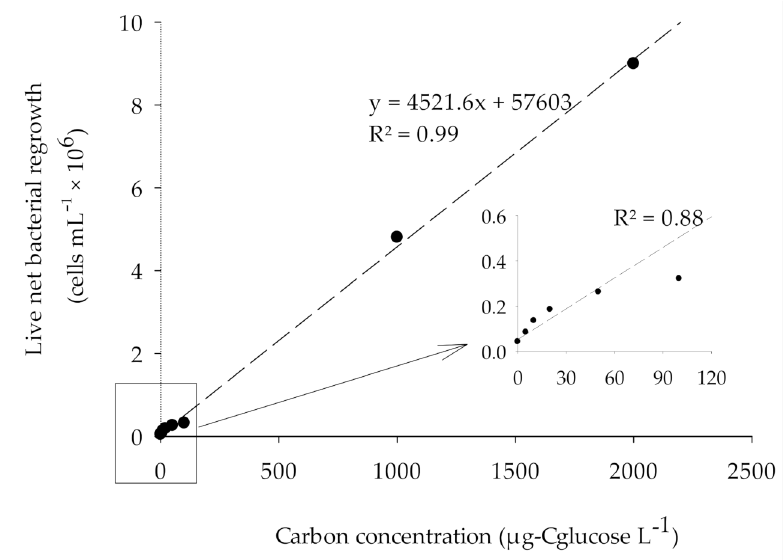
Figure 5. The correlation between the live bacterial net regrowth and carbon concentration (0–2000 µ g-C glucose /L) in ASW sample.